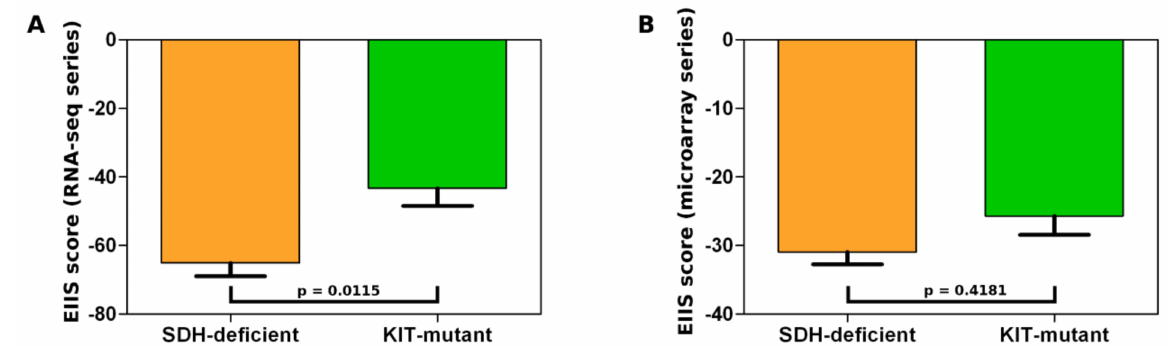
Figure 5. IFN- γ -induced immune signature (EIIS) score in SDH-deficient GISTs (orange box) and KIT-mutant GISTs (green box) computed for the microarray series ( A ) and for the RNA-seq samples ( B